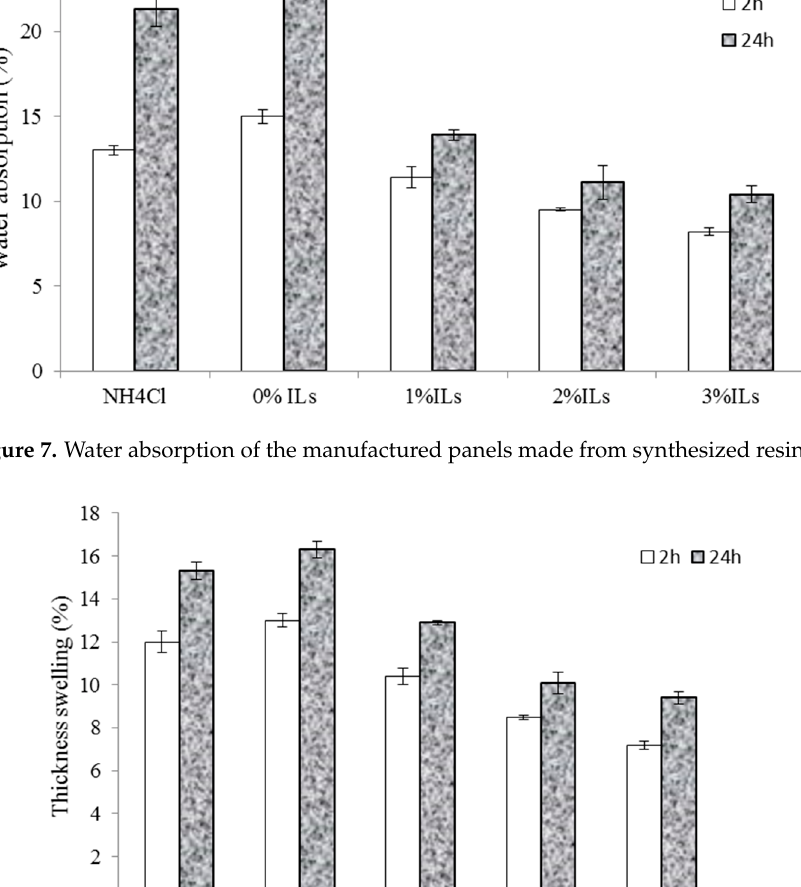
Figure 9. Flexural modulus of the manufactured panels made from synthesized resins.